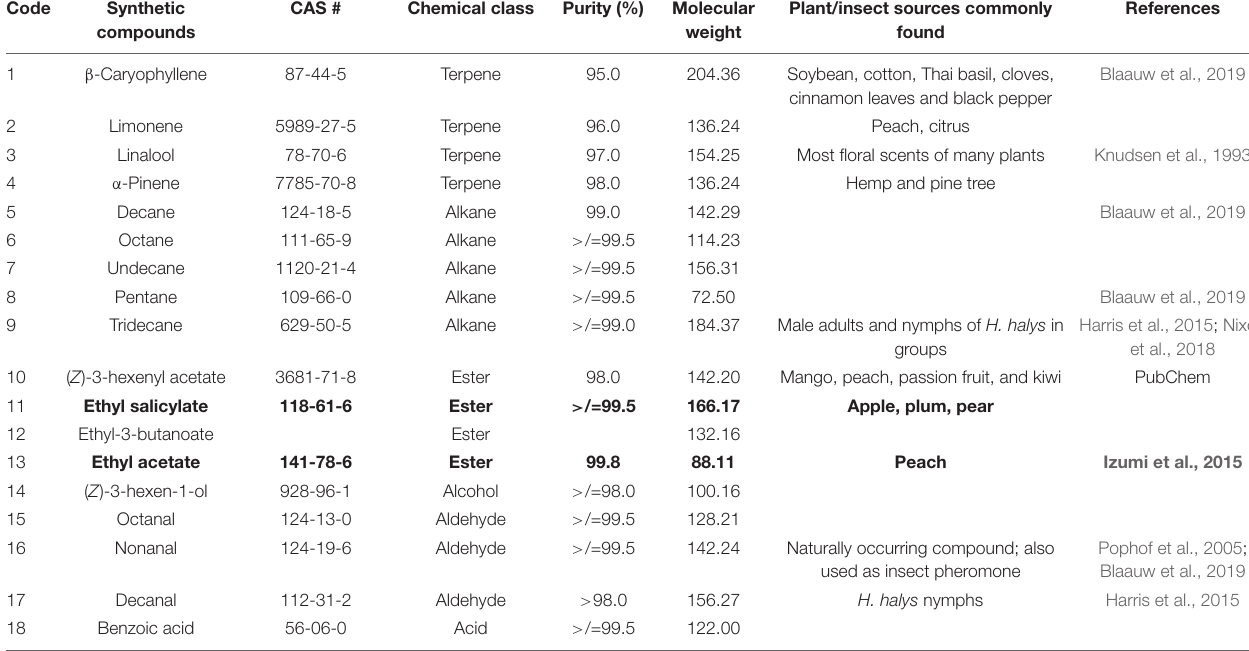
TABLE 1 | List of synthetic compounds used for the Y-tube study.